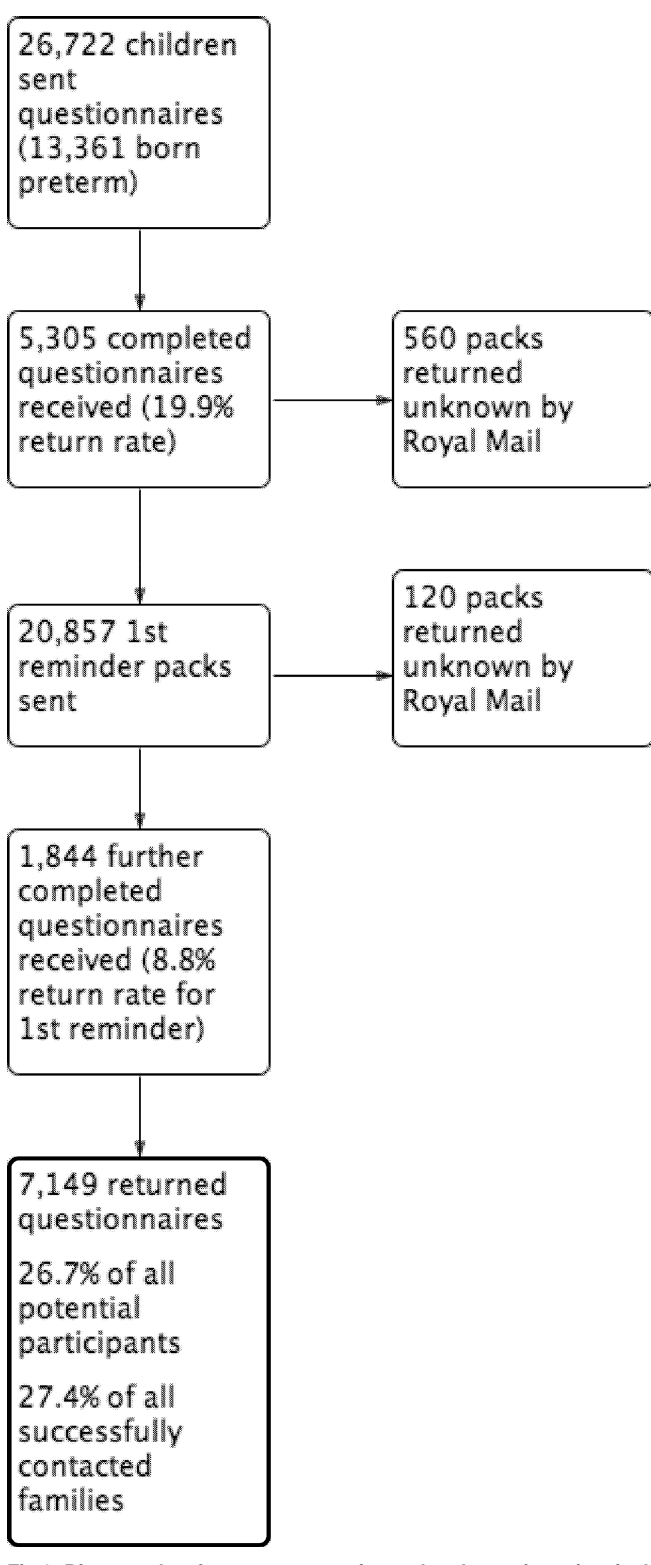
Fig 1. Diagram showing return rates of completed questionnaires in the Respiratory and Neurological Outcomes of children born Preterm Study